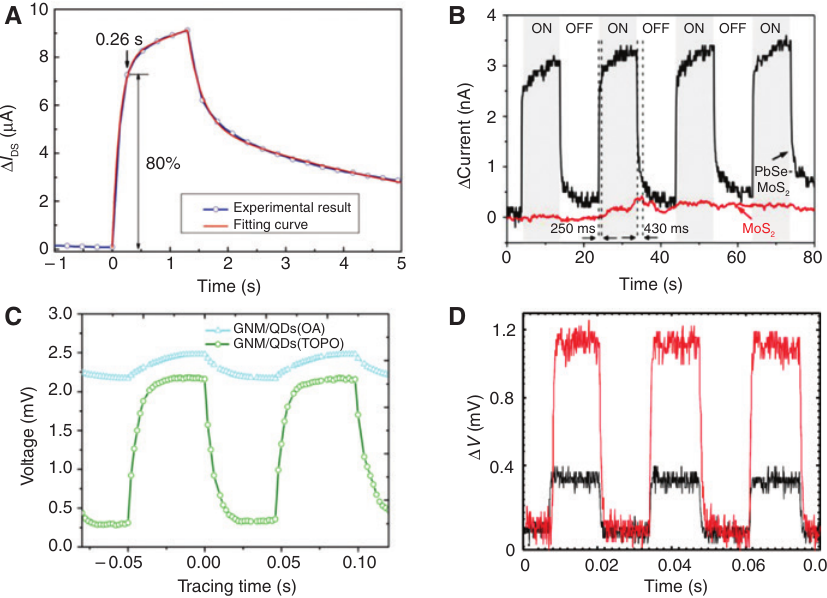
transistor with PbS QDs [16], (C) 2